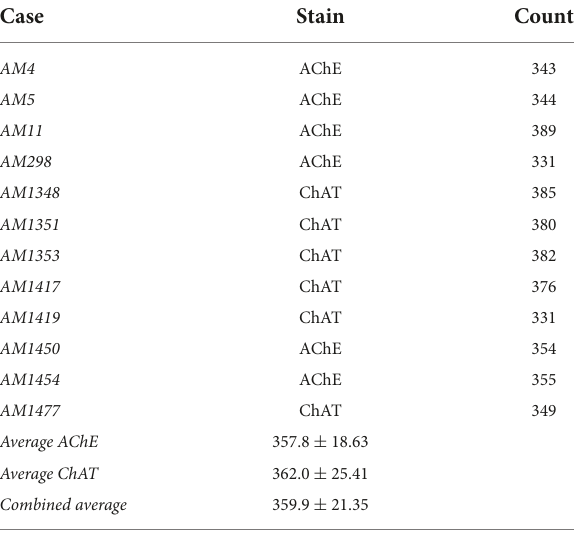
TABLE 2 Counts comparing the distribution of LOC efferents stained by AChE or